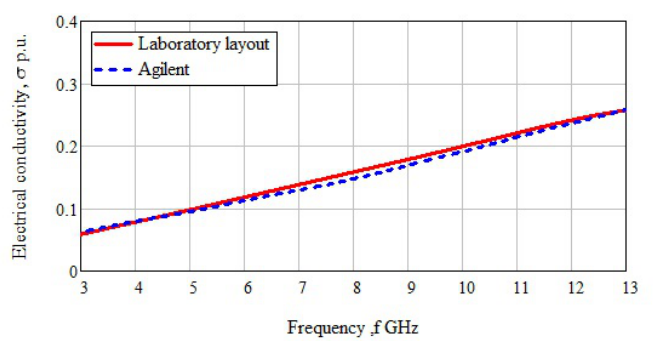
Figure 14. Electrical conductivity values for composite material measured by laboratory model (red) and proprietary Agilent equipment (blue) dependence frequency.